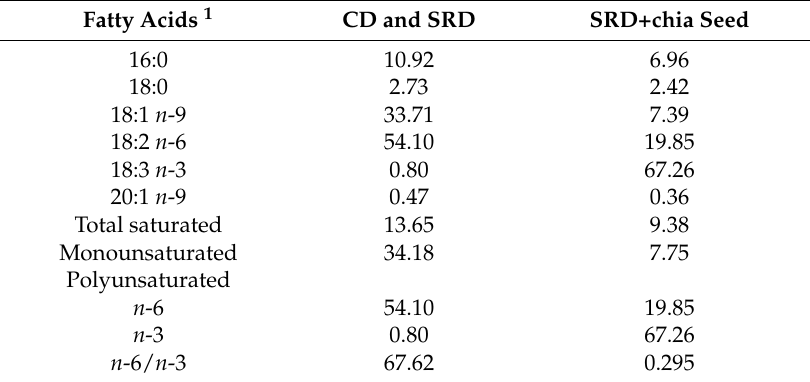
Table 2. Total fatty acid composition of experimental diets (g/kg